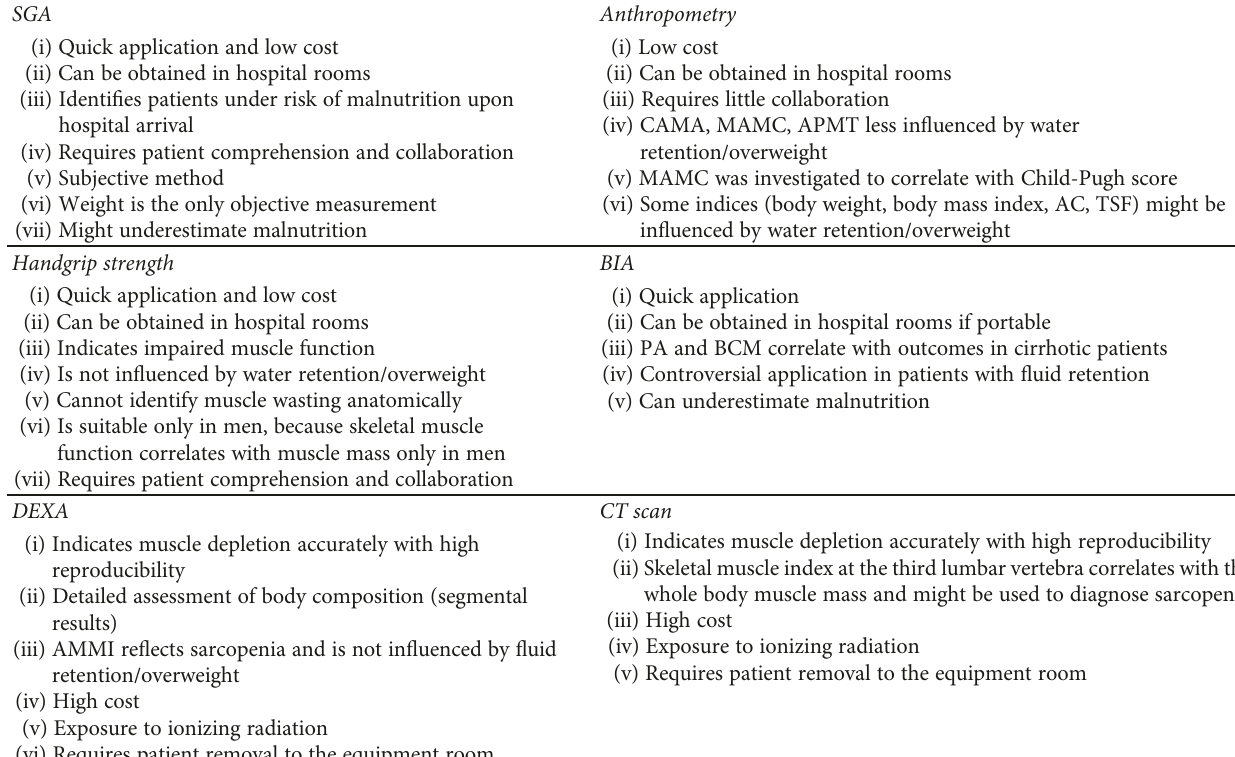
Table 1: Methods to assess nutritional status in cirrhotic patients with their advantages and